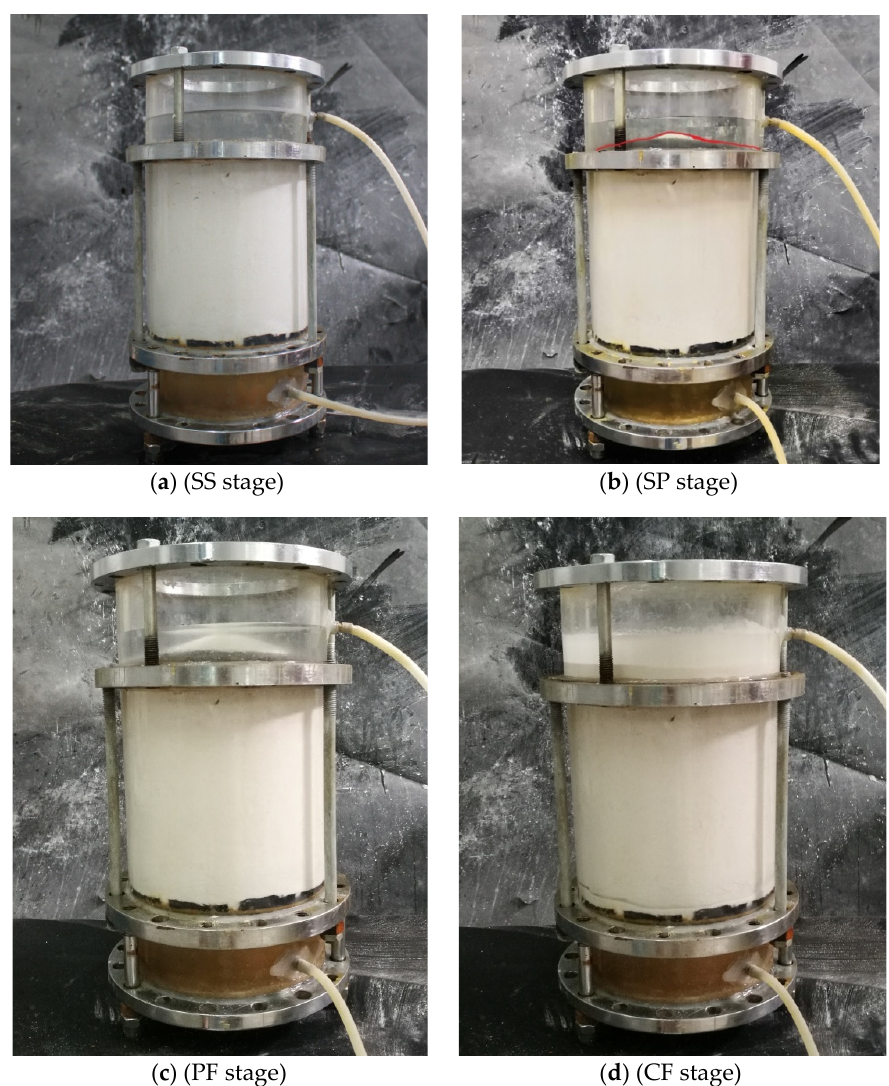
Figure 9. Images of the four seepage erosion stages (q = 0 kPa, r 0 = 1.0 cm). ( a ) Seepage stability